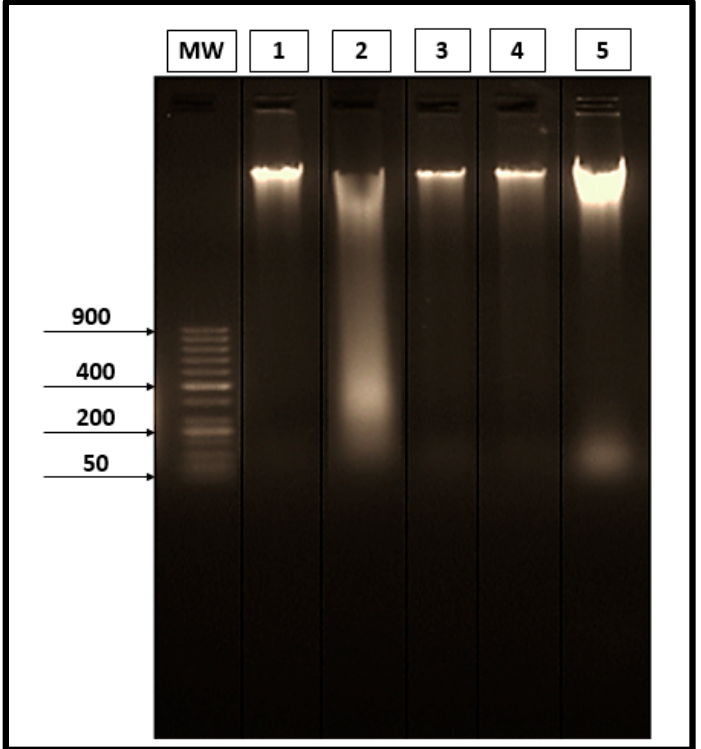
Figure 5. Electrophoretic separated genomic DNA from liver tissues. (Lane MW) 50 bp DNA ladder marker. (Lane 1) DNA extracted from the liver of the saline group. (Lane 2) DNA extracted from the liver of the infected-untreated group. (Lane 3) DNA extracted from the liver of the infected group treated with BZQ. (Lane 4) DNA extracted from the liver of the infected group treated with AL. (Lane 5) DNA extracted from the liver of the infected group treated with CU.